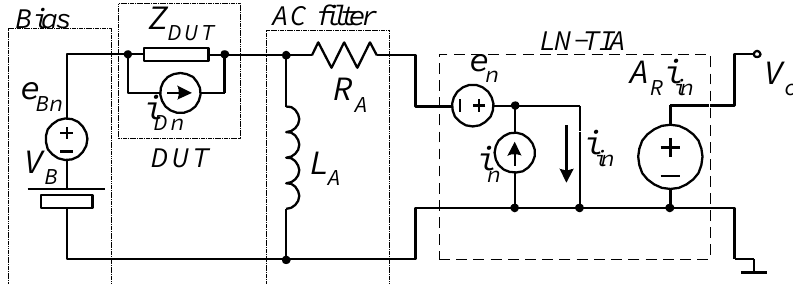
Figure 12. Ideal circuit for separating the current fluctuations entering the Low Noise Transimpedance Amplifier (LN-TIA) from the DC bias current (ideally flowing through the inductance